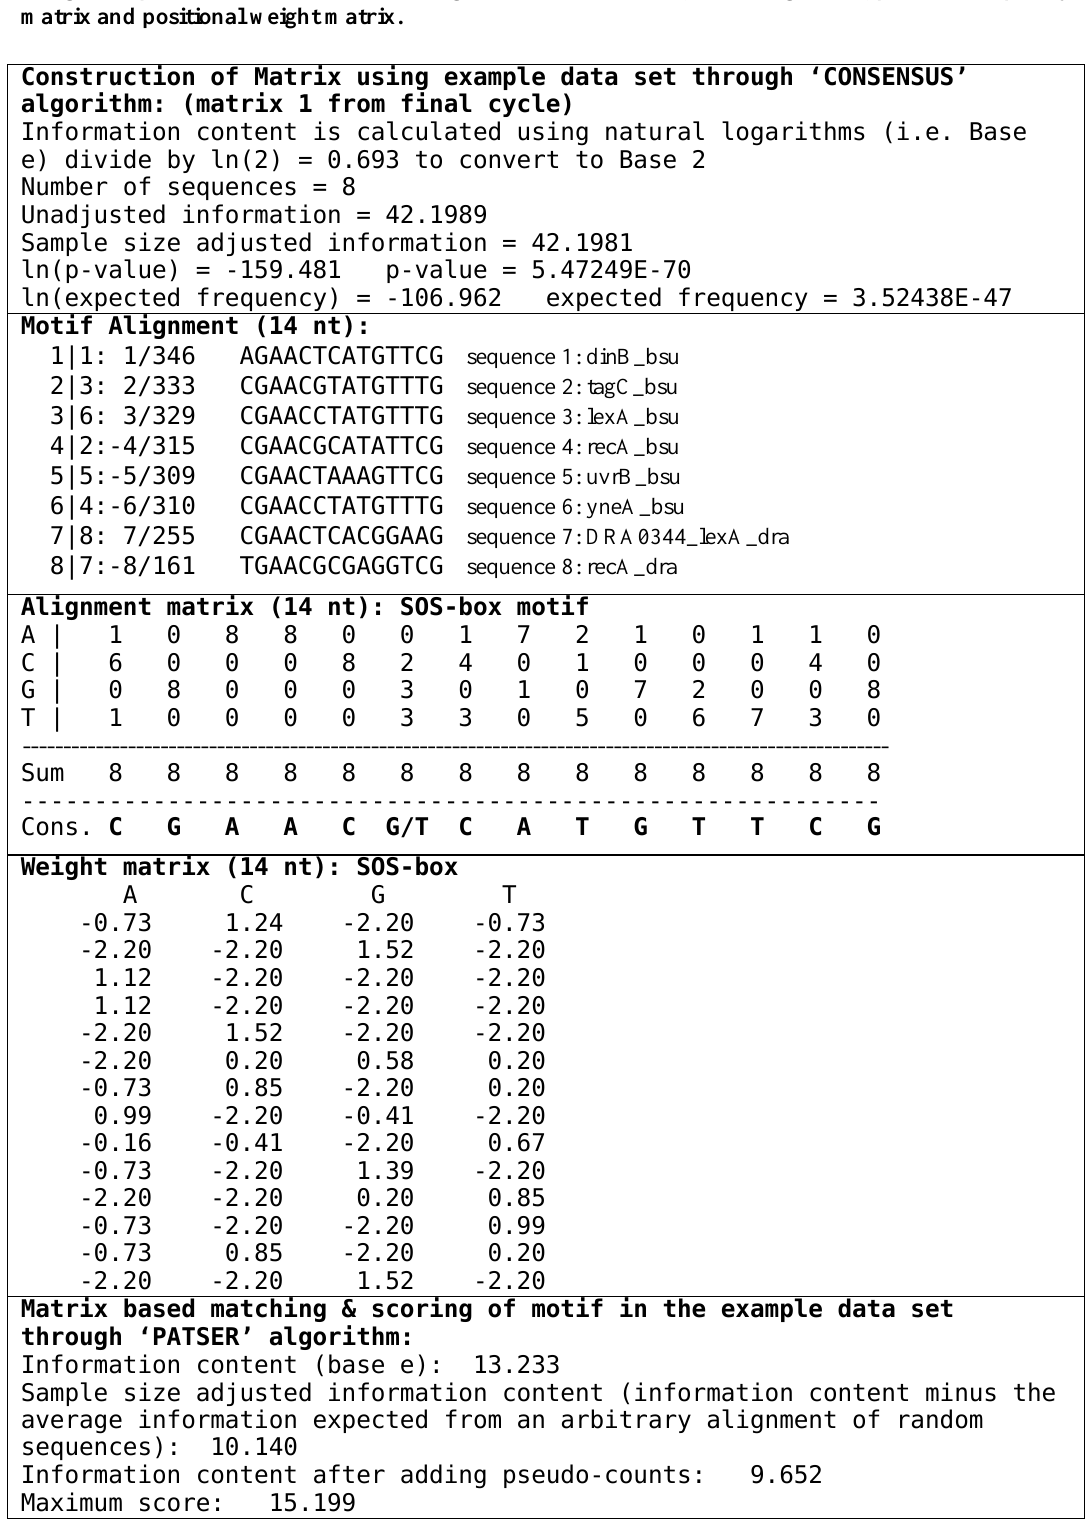
Supplementary Table 3 (S3): Details of the statistical data resulted during construction of matrix using example data set. The data showing information content, motif alignment, position frequency matrix and positional weight